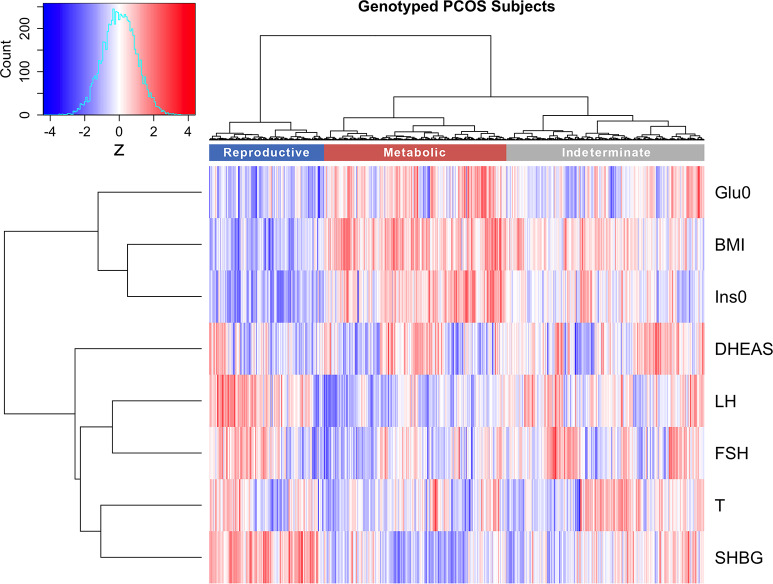
Hierarchical clustering of genotyped PCOS clustering cohort.Hierarchical clustering of 893 genotyped PCOS cases according to adjusted quantitative traits revealed 2 distinct phenotypic subtypes, a “reproductive” cluster, and a “metabolic” cluster; the remaining cases were designated as “indeterminate.” The reproductive, metabolic, and indeterminate clusters are shown in the color bar as dark blue, dark red, and gray, respectively. Heatmap colors correspond to trait z-scores, as shown in the frequency histogram in which red indicates high values and blue indicates low values for each trait. The row-based dendrogram represents relative distances between trait distributions and was calculated using the same approach as the subject-based clustering. BMI, body mass index; DHEAS, dehydroepiandrosterone sulfate; FSH, follicle-stimulating hormone; Glu0, fasting glucose; Ins0, fasting insulin; LH, luteinizing hormone; PCOS, polycystic ovary syndrome; SHBG, sex hormone binding globulin; T, testosterone.